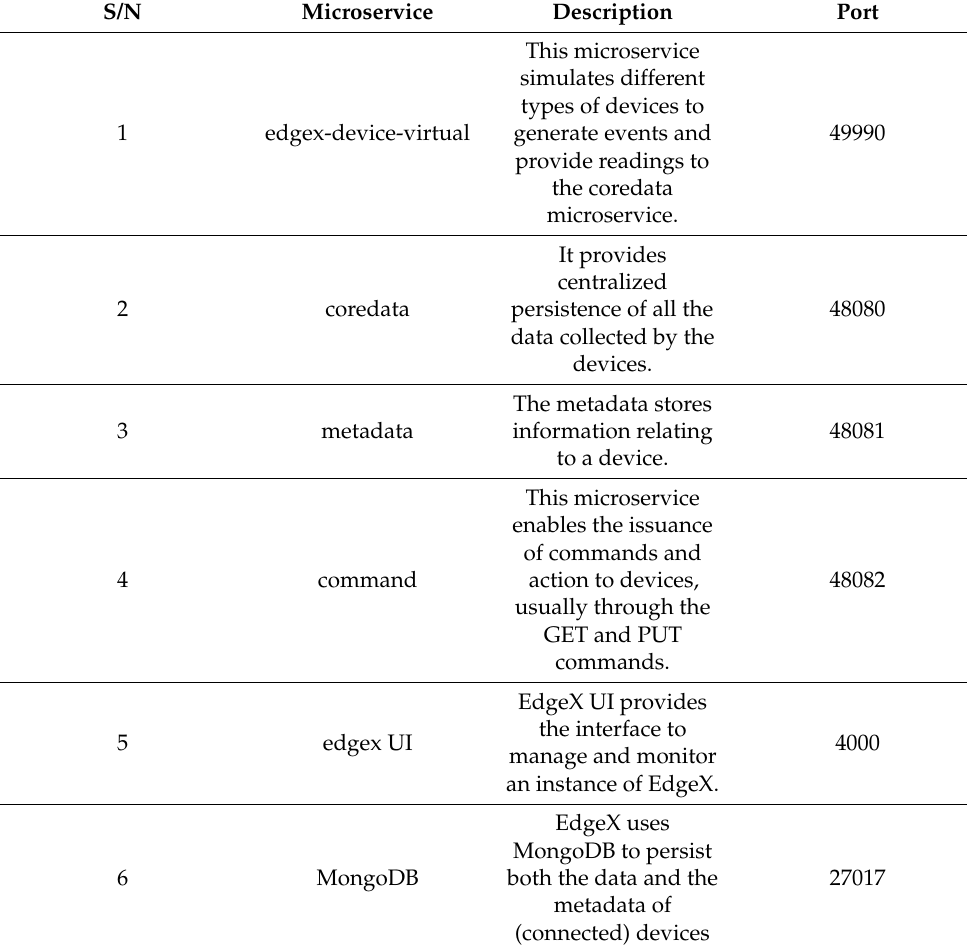
Table 2. Selected EdgeX microservices description and their respective port